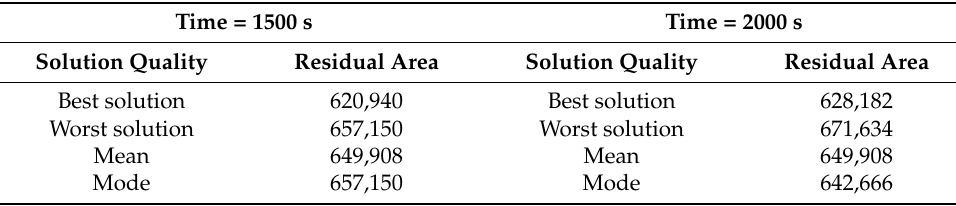
Table 5. ILS behavior with different execution times (residual area).